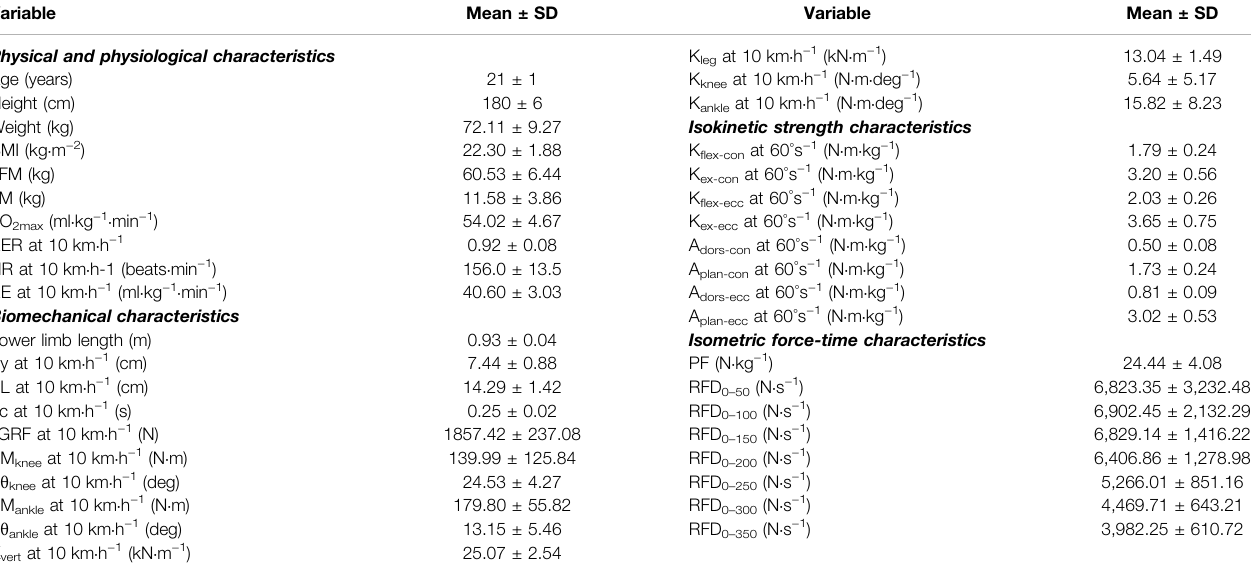
TABLE 1 | Physical, physiological, and neuromuscular characteristics of the participants ( n = 30). Variable Physical and physiological